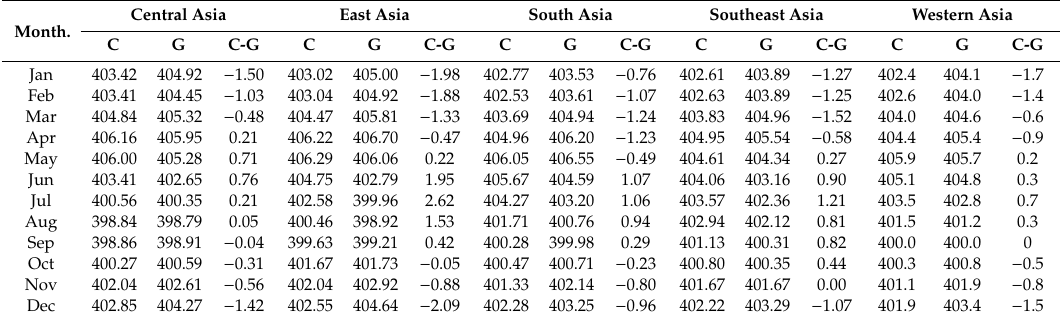
Table 4. Monthly averaged XCO 2 concentration derived from the CT (C), GOSAT (G), and their di ff erences (C-G). The statistics are computed for 5 years over Central Asia, East Asia, South Asia, Southeast Asia and Western Asia. (Unit: ppm). Month.